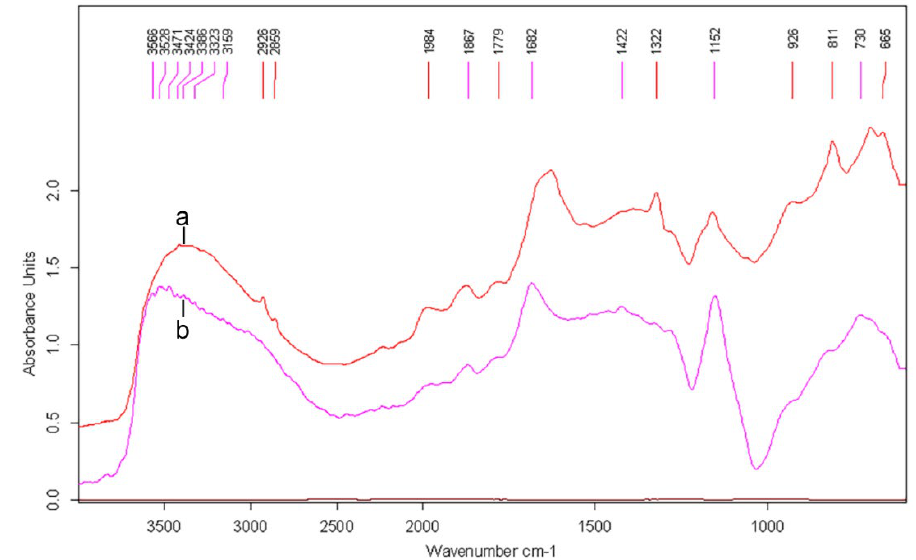
Figure 15. FTIR spectrum for the red pigment from Piatra Neamt- Bâtca Doamnei (a-interior; b-exterior).